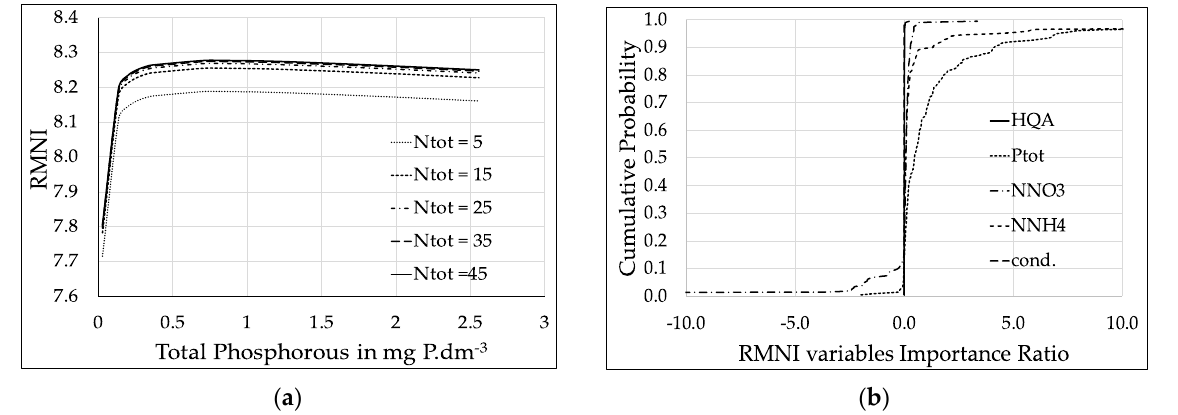
Figure 2. ( a ) Total nitrogen–total phosphorous nonlinear relationship with RMNI; ( b ) importance ratio of independent variables with RMNI.